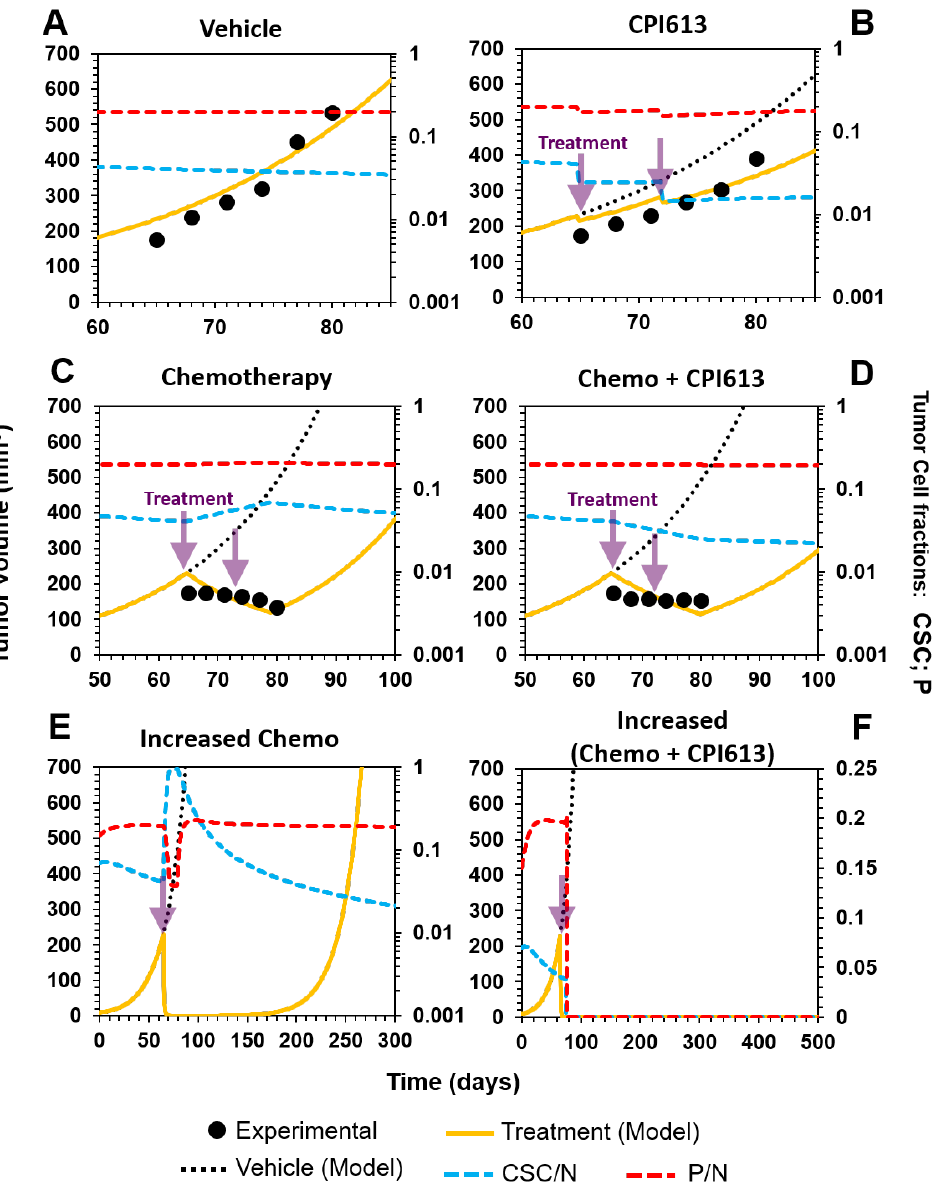
Figure 8. Combination treatment of ovarian cancer. ( A ) Control treatment with a vehicle. ( B ) Selective targeting of CSCs by treatment with CPI613. ( C ) Chemotherapy based on carboplatin and paclitaxel. ( D ) Combination therapy (chemotherapy + selective targeting of CSCs). ( E ) Augmentation of the chemotherapy dose retarded tumor relapse, but did not eliminate the disease. ( F ) Treatment in ( E ), combined with an increased dose of CPI613, produced a better response than either treatment alone. Furthermore, tumor relapse was not observed. For all cases: Experimental data are represented by black points; model simulation by solid yellow lines; control treatment by a dotted black line; and P and CSC tumor fractions by dashed red and blue lines, respectively. The treatment time is represented with purple arrows.